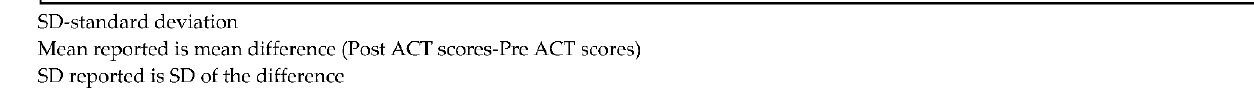
Figure 9. Forest plot comparing Depression, Anxiety and Stress Scale-21 (Anxiety) scores between parents of children with SHCN who received ACT and parents of children with SHCN who received no